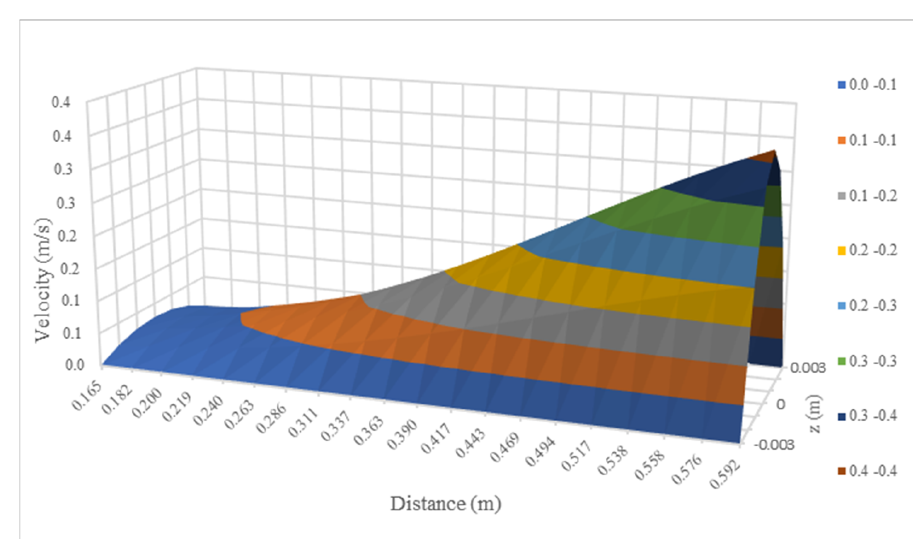
Mathematics 2021 , 9 , 2907 Figure 16. Three -dimensional velocity distribution. Figure 16. Three -dimensional velocity distribution.